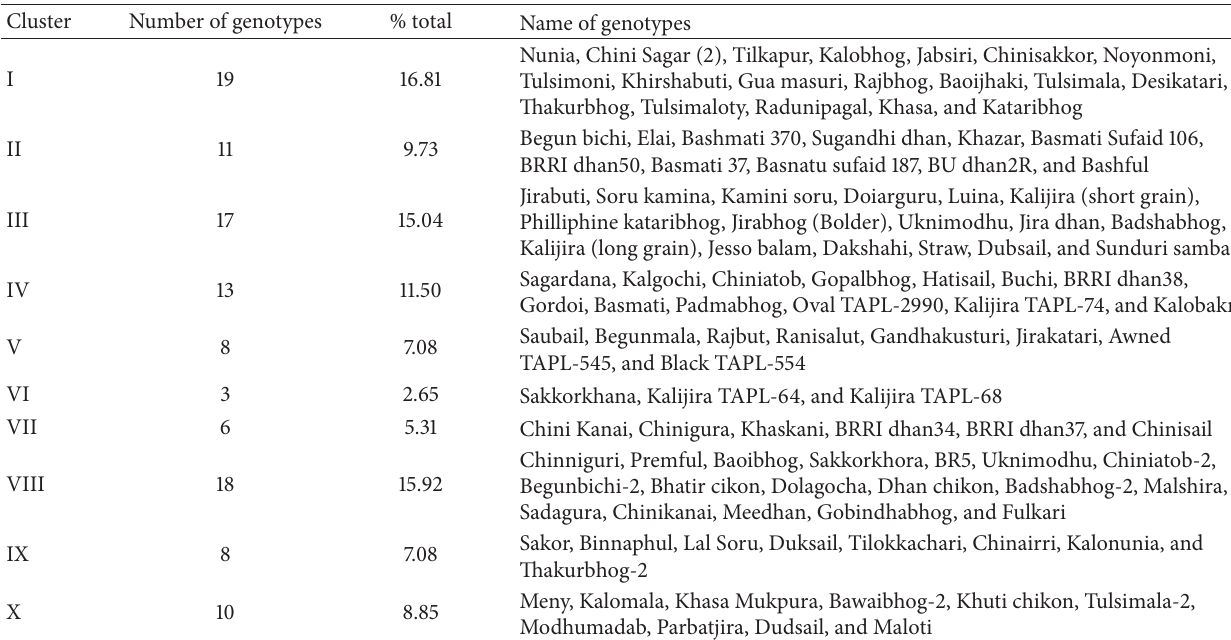
Table 8: Distribution of 113 aromatic and fine rice genotypes into ten clusters.